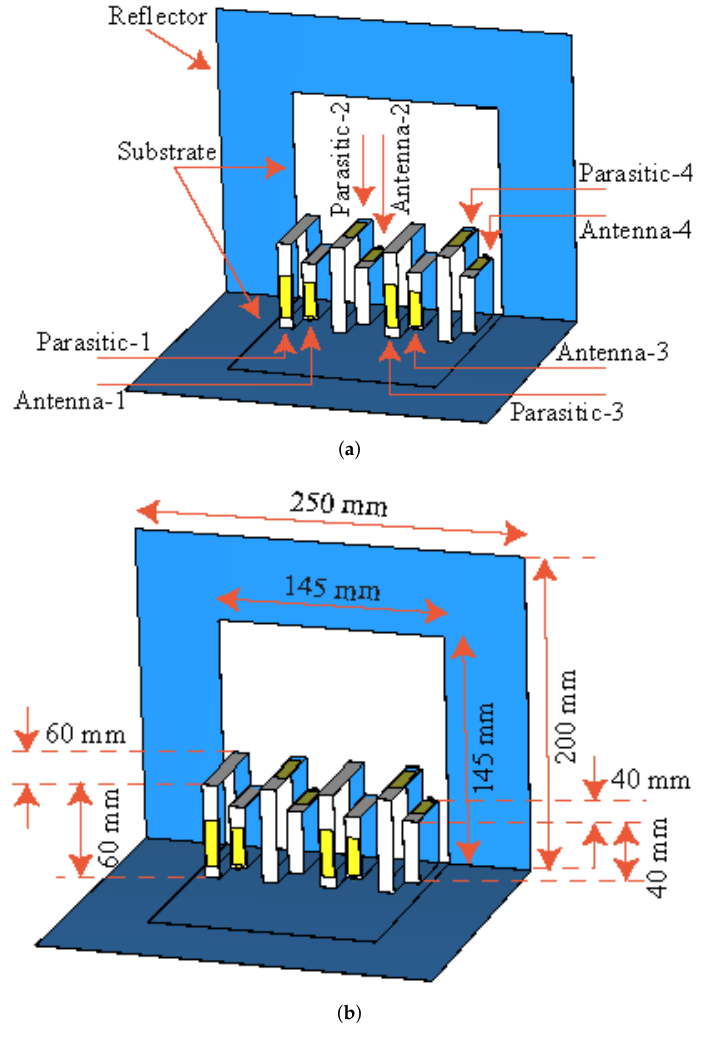
Figure 1. Front view of the proposed Kirigami MIMO antenna ( a ) with each element label and ( b ) with the